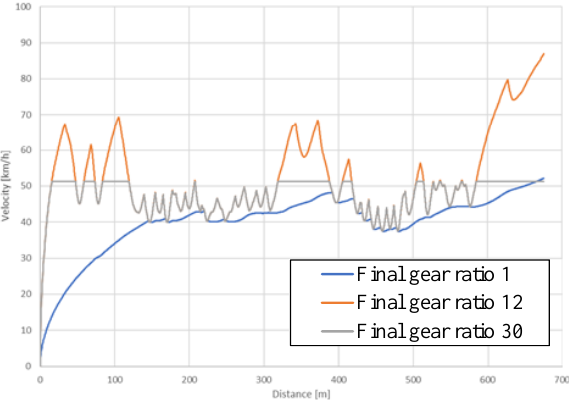
Figure 14. Relationship between distance and vehicle velocity for each final gear ratio.